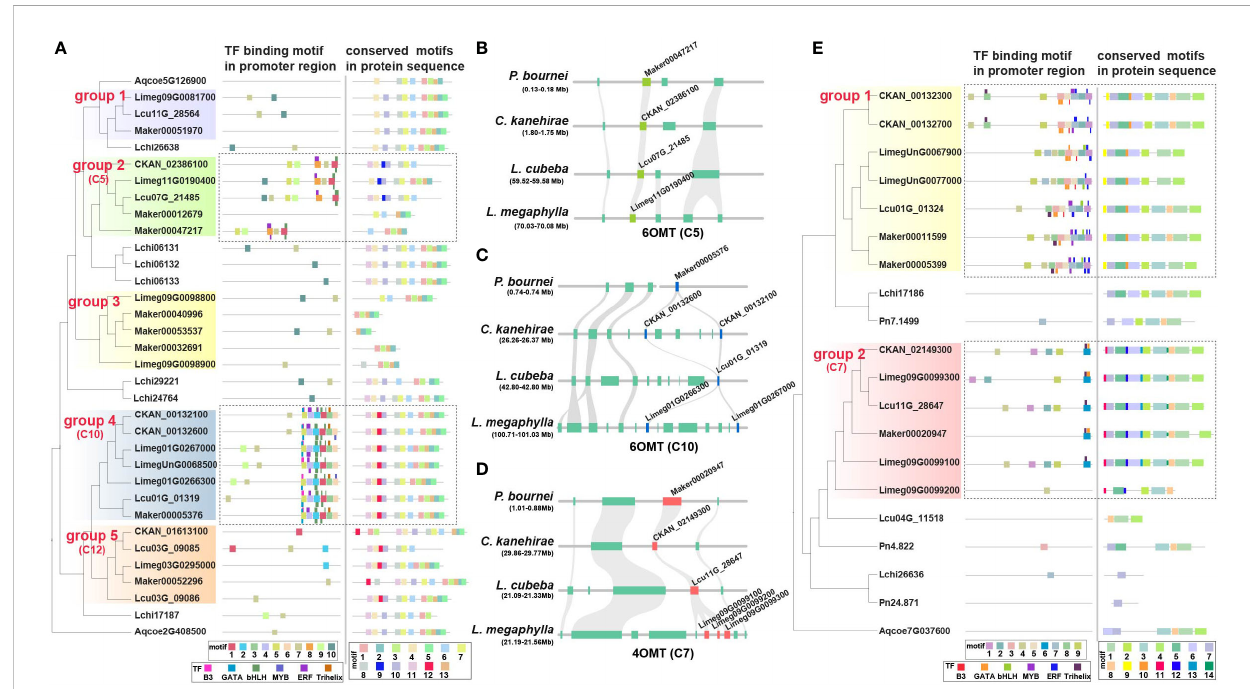
FIGURE 5 Speci fi city of 6OMT and 4OMT genes in Lauraceae. (A) The different panels illustrate the phylogenetic tree of the 6OMT gene family (left), the distribution of motifs in the promoter sequences and the predicted transcription factor binding sites (TFBS) (middle), and the distribution of motifs in protein sequences (right). Thick squares represent motifs and thin ones represent TFBSs. Dashed boxes highlight genes and promoter motifs unique to Lauraceae species. (B) The syntenic block containing the 6OMT gene family within the Lauraceae-speci fi c microsynteny gene cluster (C5), which was identi fi ed in Figures 4D, E. This syntenic block was compared among P. bournei , C. kanehirae , L. cubeba , and L. megaphylla . Chartreuse squares represent the 6OMT genes and aquamarine squares represent other genes on the syntenic block. (C) The syntenic block containing the 6OMT gene family within the Lauraceae-speci fi c microsynteny gene cluster (C10), which was identi fi ed in Figures 4D, E. This syntenic block was compared among P. bournei , C. kanehirae , L. cubeba , and L. megaphylla . Blue squares represent 6OMT genes and aquamarine squares represent other genes on the syntenic block. (D) The syntenic block containing the 4OMT gene family within the Lauraceae-speci fi c microsynteny gene cluster (C7), which was identi fi ed in Figures 4D, E. This syntenic block was compared among P. bournei , C. kanehirae , L. cubeba , and L. megaphylla . Red squares represent 4OMT genes and aquamarine squares represent other genes on the syntenic block. (E) The different panels show the phylogenetic tree of the 4OMT gene family (left),the distribution of motifs in the promoter sequences and the predicted transcription factor binding sites (TFBS) (middle), and the distribution of motifs in protein sequences (right). Thick squares represent motifs and thin ones represent TFBSs. Dashed boxes highlight genes and promoter motifs unique to Lauraceae